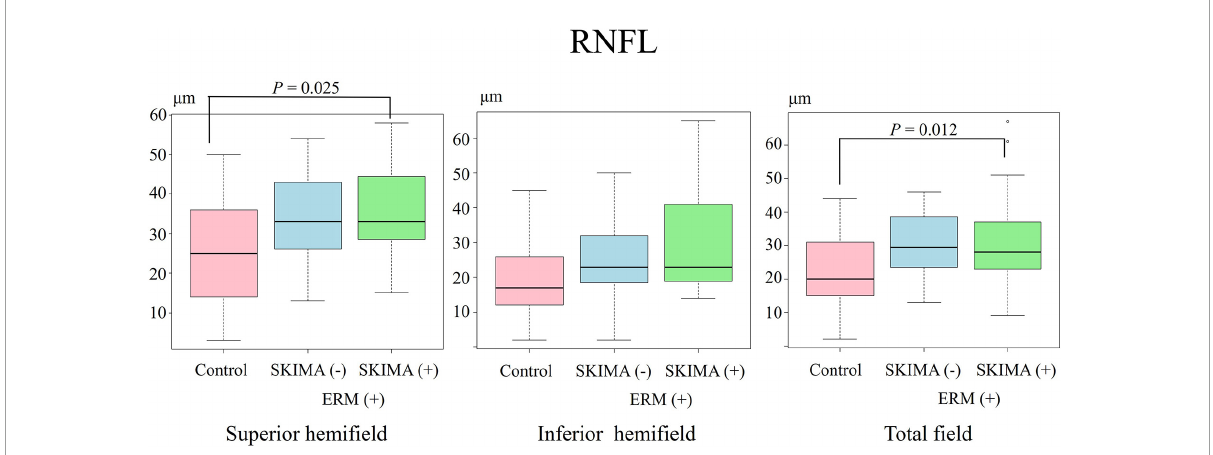
FIGURE2 Effect of SUKIMA on RNFL thickness. Superior hemifield (Left panel) significant difference was found between the SUKIMA (+) and control groups. Inferior hemifield (Middle panel) no significant difference was found among the groups. Total field (Right panel) significant difference was observed between the SUKIMA (+) and control groups.